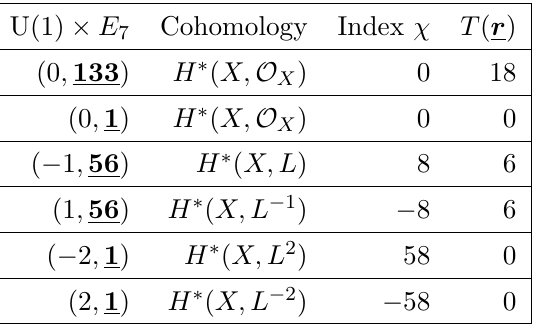
Table 1 : The chiral spectrum for the hidden sector U (1) × E (2 , 1 , 3) . The Euler characteristic (or index) χ gives the difference between the L = O X number of right- and left-chiral fermionic zero-modes transforming in the given